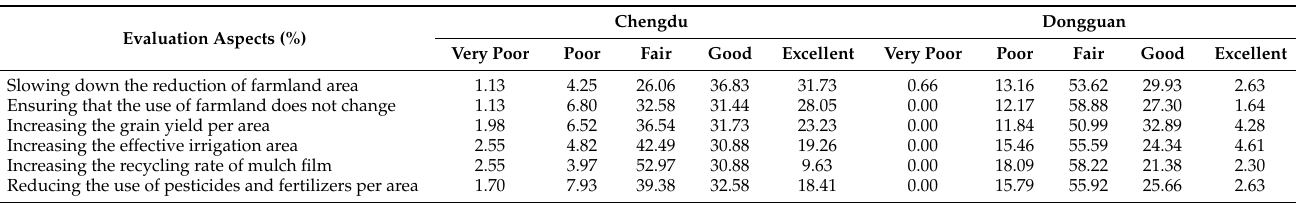
Table 9. Rural households’ multidimensional perceptions of the performance of